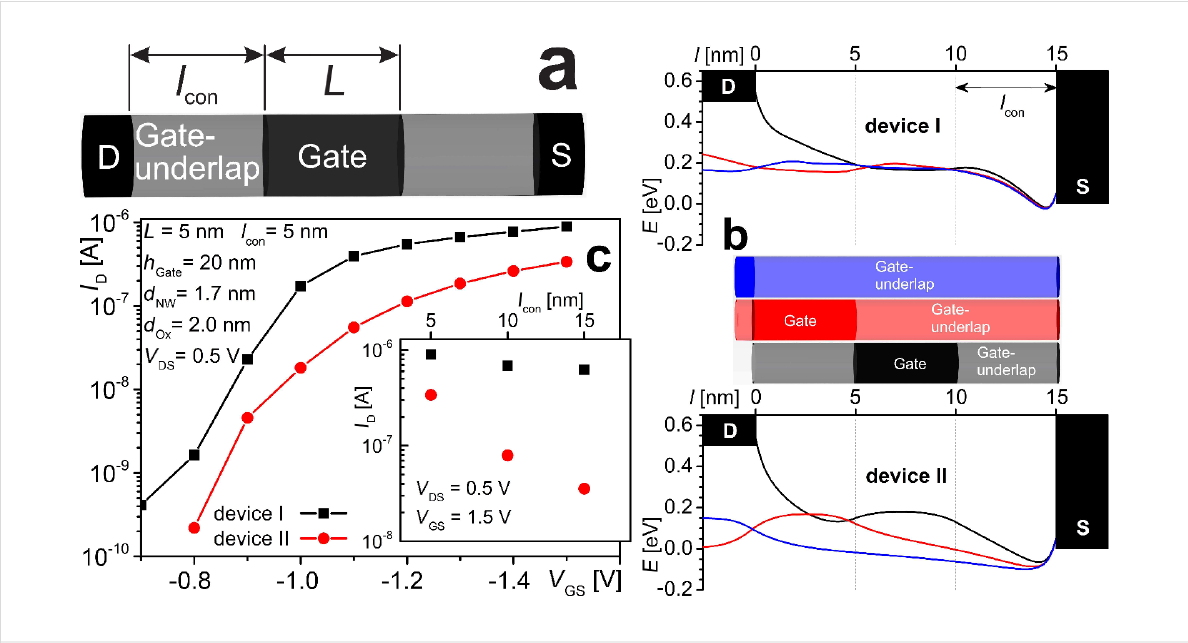
Figure 8: NEGF simulation results of undoped Si-NWire-FET illustrated in Figure 7: (a) gate-wrap-around Si-NWire FET showing parameters listed in graphs (b) and (c). (b) Valence band along the axis of device I (top, Si 3 N 4 -coated gate-underlap) and device II Si-NWire FET (bottom, entire Si-NWire SiO 2 -coated) in on-state-mode with V GS = − 1.2 V. The centre schematic shows the NWire-FET device gate-position and gate-underlap. Schottky- potential barriers build up although the same Schottky-barrier-height at the metal–Si interface at drain and source were chosen in both devices to ex- amine the effectiveness of “doping” (Si 3 N 4 -coating) of underlap areas. A shift of the Schottky-barrier for device II due to workfunction mismatch of Ni to the valence band of the SiO 2 -coated Si-NWire would lead to a further massive deterioration of the on-state performance of device II. (c) Transfer characteristics of device type I (black) and II (red) for V DS = 0.5 V, contact length l con = 5 nm; the graph contains remaining parameters. The “doping” generated via ICT yields a substantially higher on-state performance in device I vs device II (no Si 3 N 4 -coated gate-underlap), an effect that